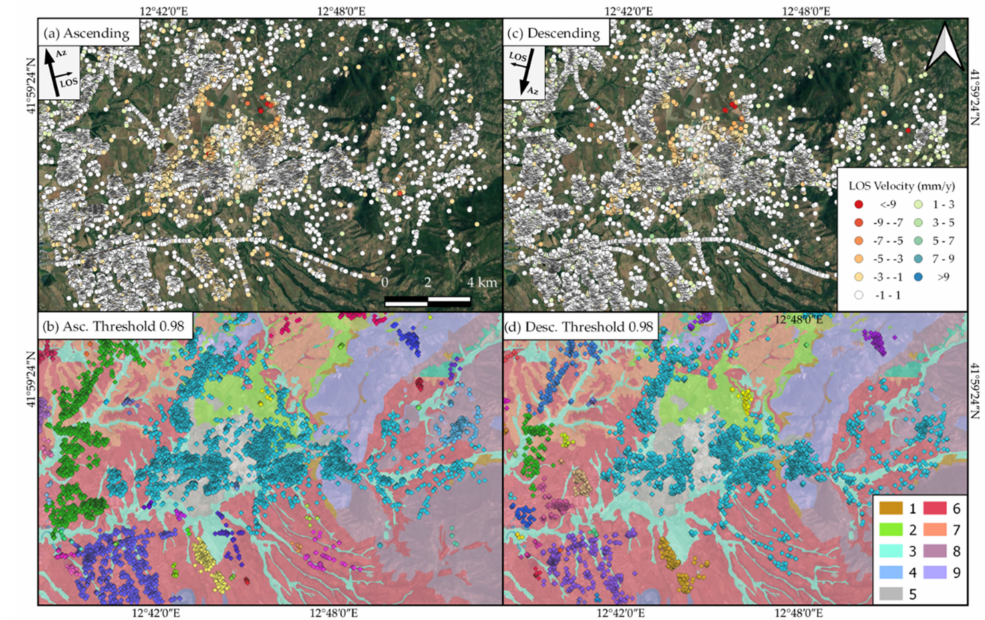
Figure 15. The area of Tivoli to the east of Rome. In ( a , c ) the PS distribution in ascending and descending mode, respectively. In ( b , d ) the distribution of the identified PS Families overlaid to the lithologic chart